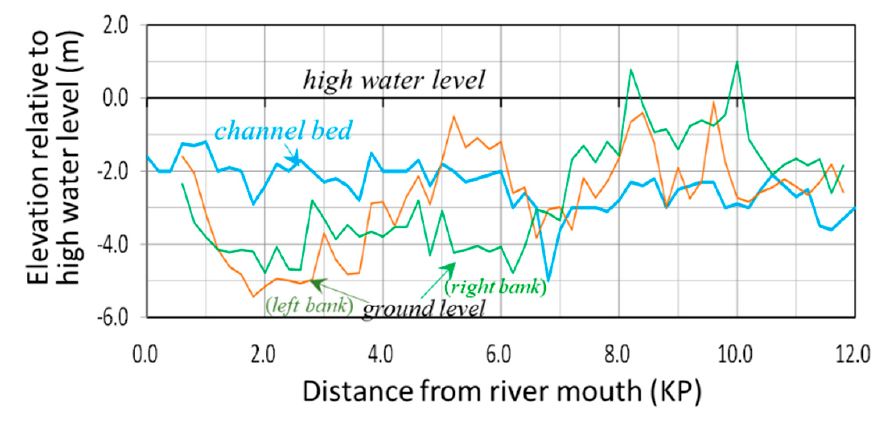
Figure 8. Longitudinal profiles of riverbed and river banks. The line of the channel bed intersects those of the riverbanks around 6 km from the river mouth. According to the contour map in Figure 1, the ground elevation of the alluvial fan in this location is about 45 m above sea level, corresponding to the intersection point of the long-term topographic change shown in Figure 2. These data suggest that concentrating the flow into a single narrow channel enlarged the vertical topographic change and that the deformation of river channel bed shown in Figure 3b probably started after the construction of the levee